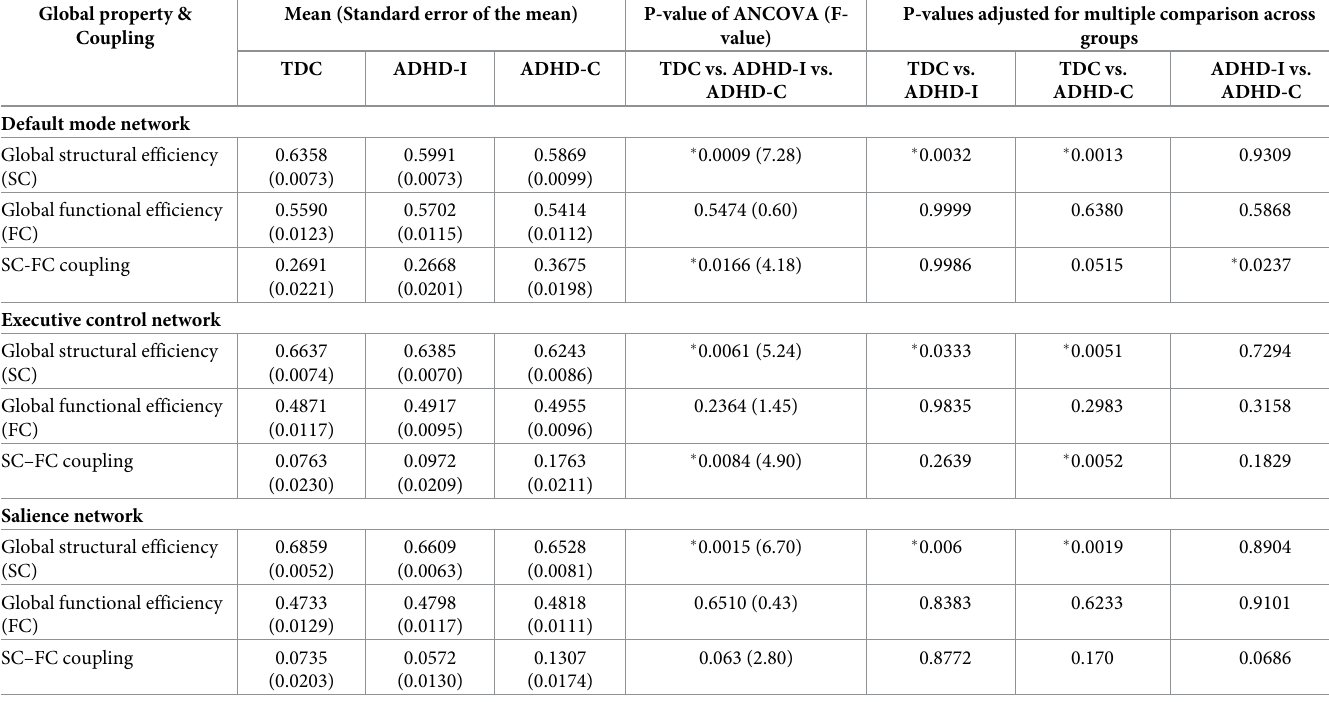
Table 2. Global network efficiency of structural connectivity (SC) and functional connectivity (FC), and the SC-FC couplings in ADHD-related subnetworks. Global property &